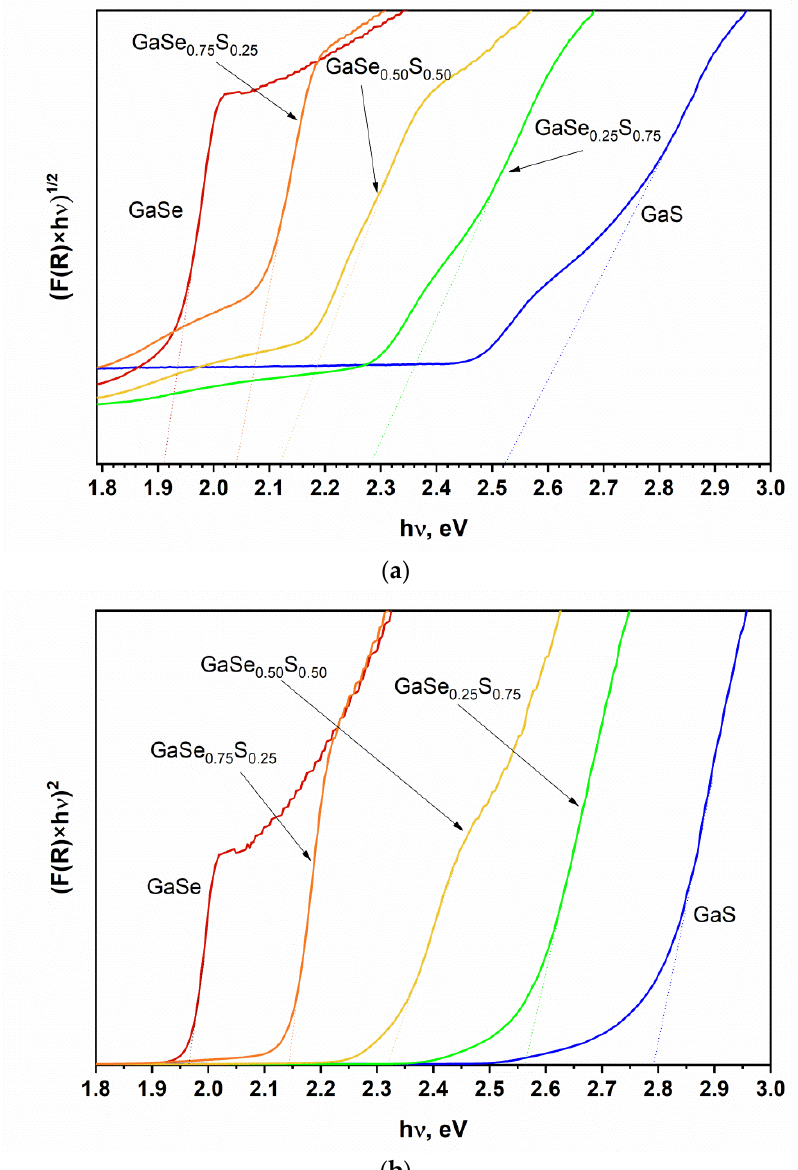
Figure 9. K-M plots of GaSe 1 − x S x films. ( a ) indirect transition ((F(R)hν) 1/2 vs. hν) and ( b ) direct transition energy ((F(R)hν) 2 vs. hν) .